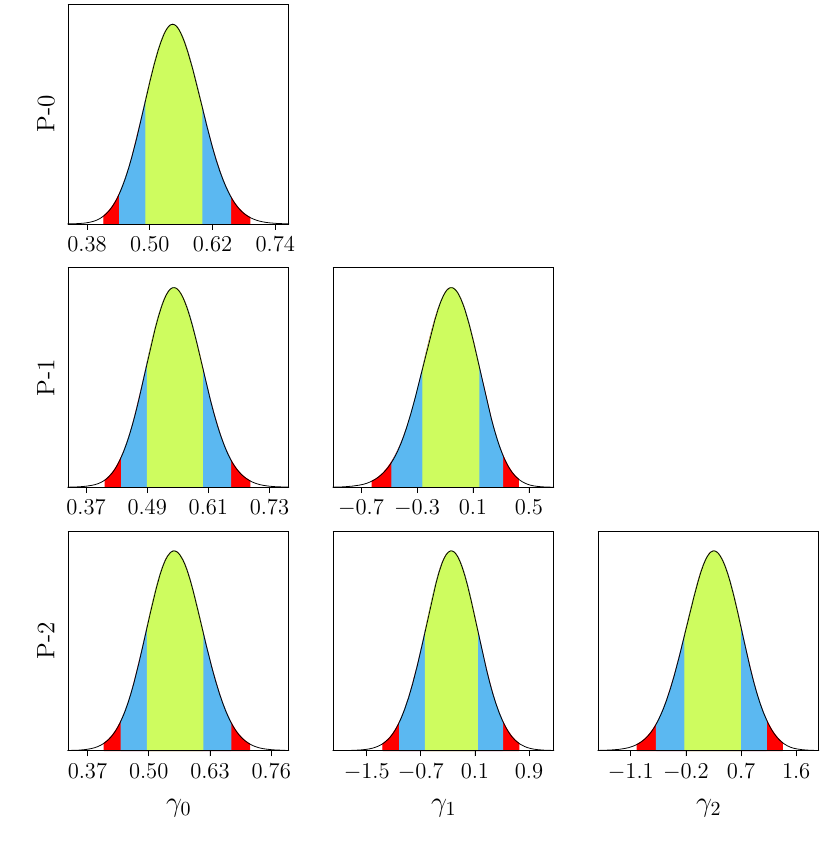
Fig. 3 The same as in Fig. 1, except for the P-0, P-1, P-2 cases. See the text and Table 4 for